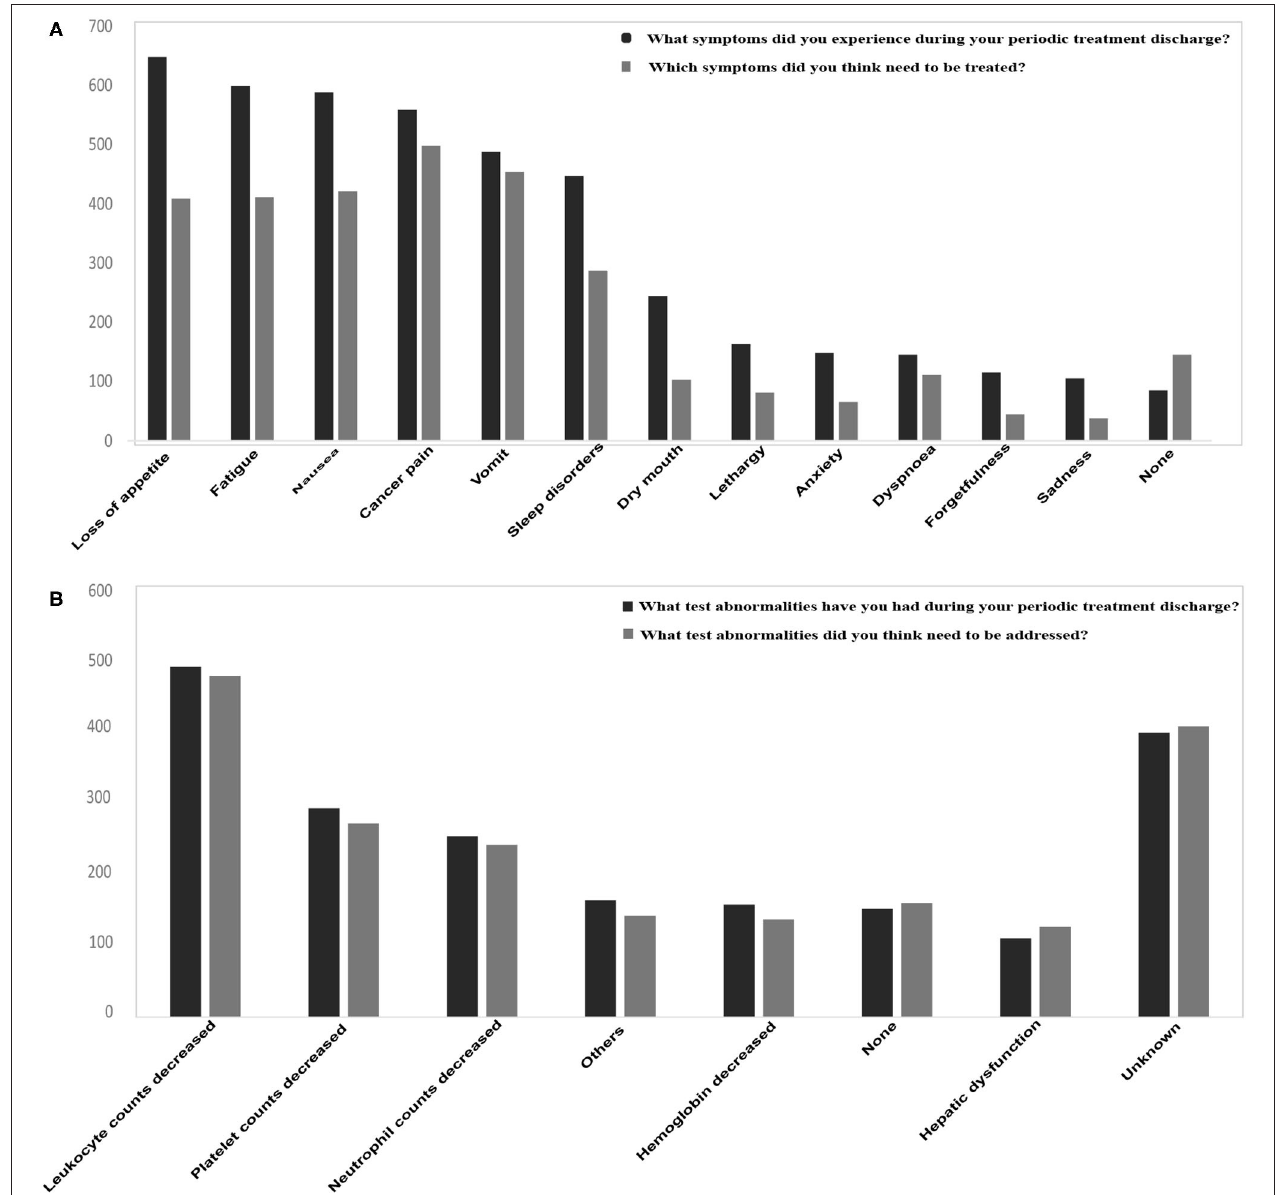
FIGURE 1 | Patients, out-of-hospital symptoms (A) and examination (B)